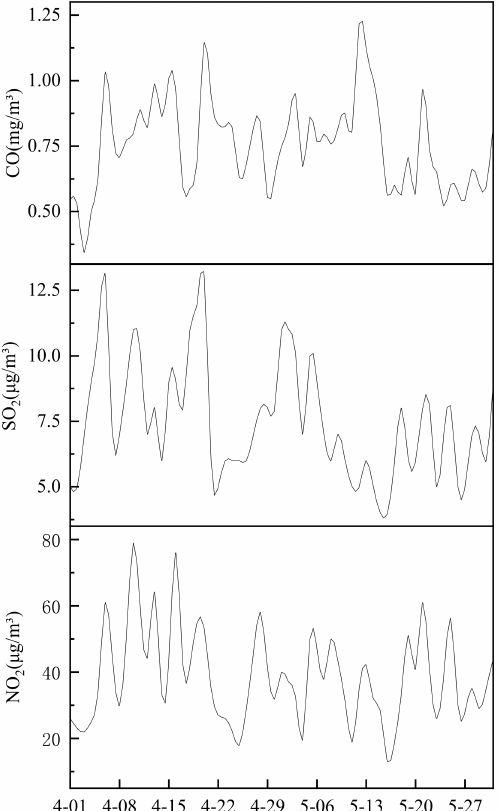
Figure 8. Variation diagram of CO, SO 2 and NO 2 mass concentration during